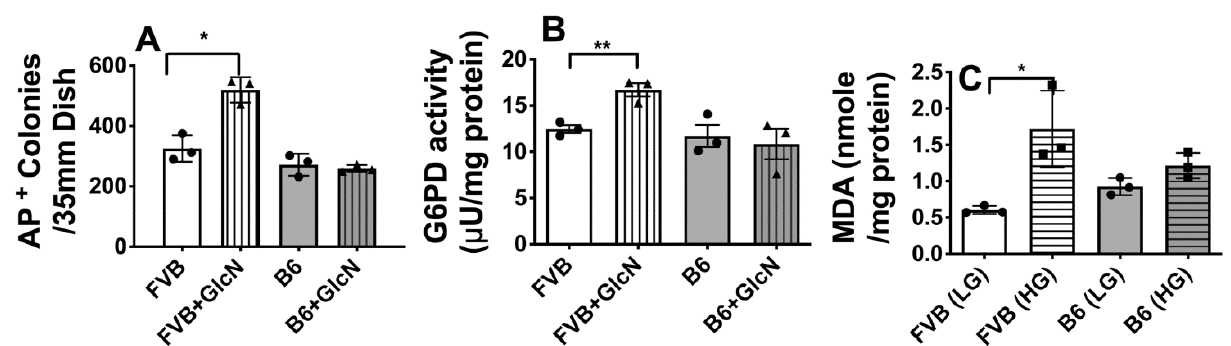
Figure 4. Relationships between differences in GlcN utilization on GlcN stimulation of growth, pentose phosphate pathway (PPP) activities, and high glucose-induced oxidative stress between FVB and B6 LG-ESC. ( A ) Alkaline phosphatase-positive (AP+) colonies following culture in low glucose media ± 0.8 mmol/L GlcN. ( B ) G6PD enzyme activity by FVB and B6 LG-ESC cultured ± 0.8 mmol/L GlcN. ( C ) Intracellular malondialdehyde (MDA) concentrations in FVB or B6 LG-ESC cultured for 8 h in low or high glucose media. Data shown are means ± SEM and were analyzed by Student t test (B) * p < 0.05; ** p < 0.01.